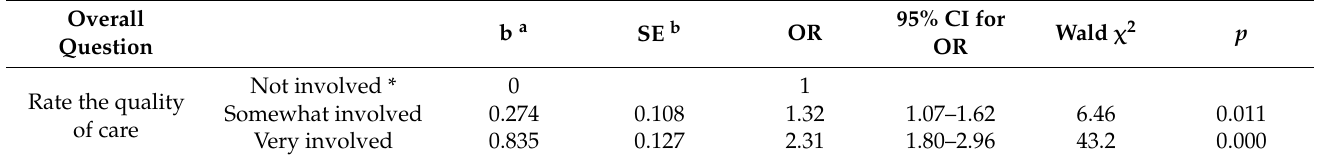
Table 3. Ordinal regression analysis summary for family doctor involvement on overall experience